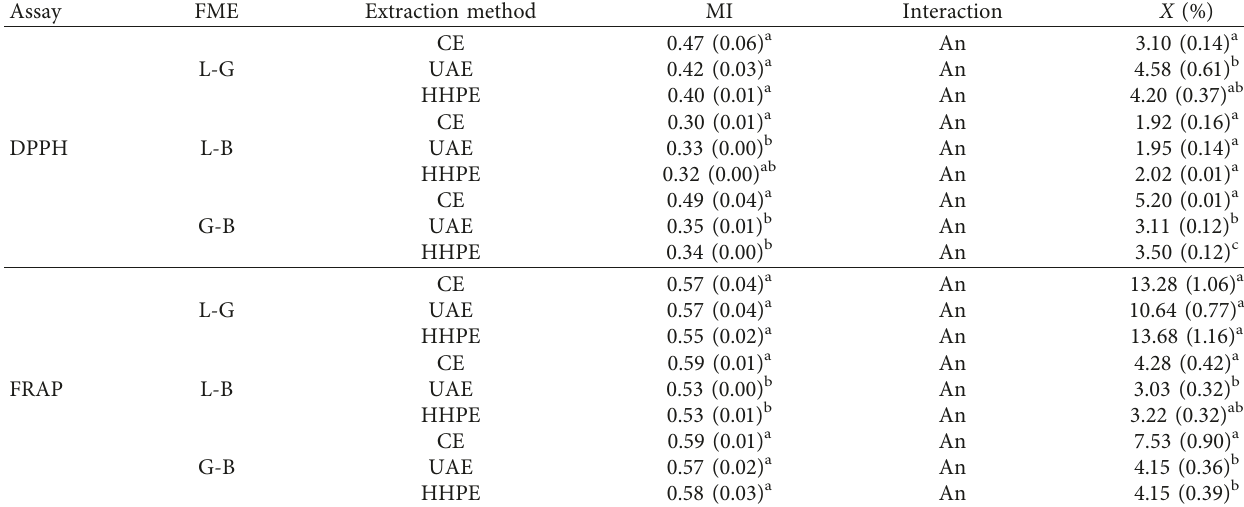
Table 3: Mixture index (MI) and regeneration percentage of DPPH and FRAP assays from fruit mixtures.